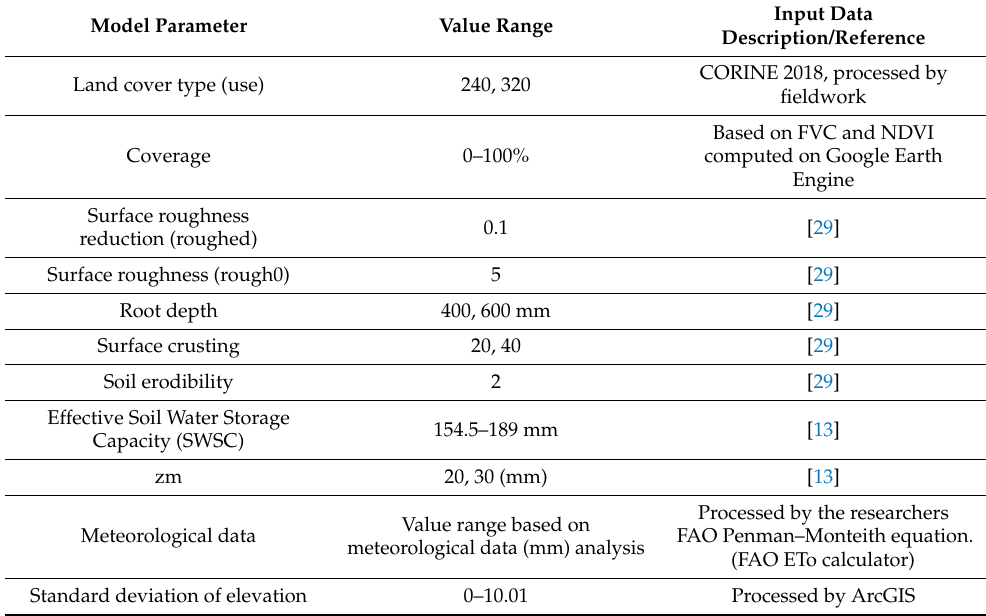
Table A7. PESERA zm estimation according to soil texture